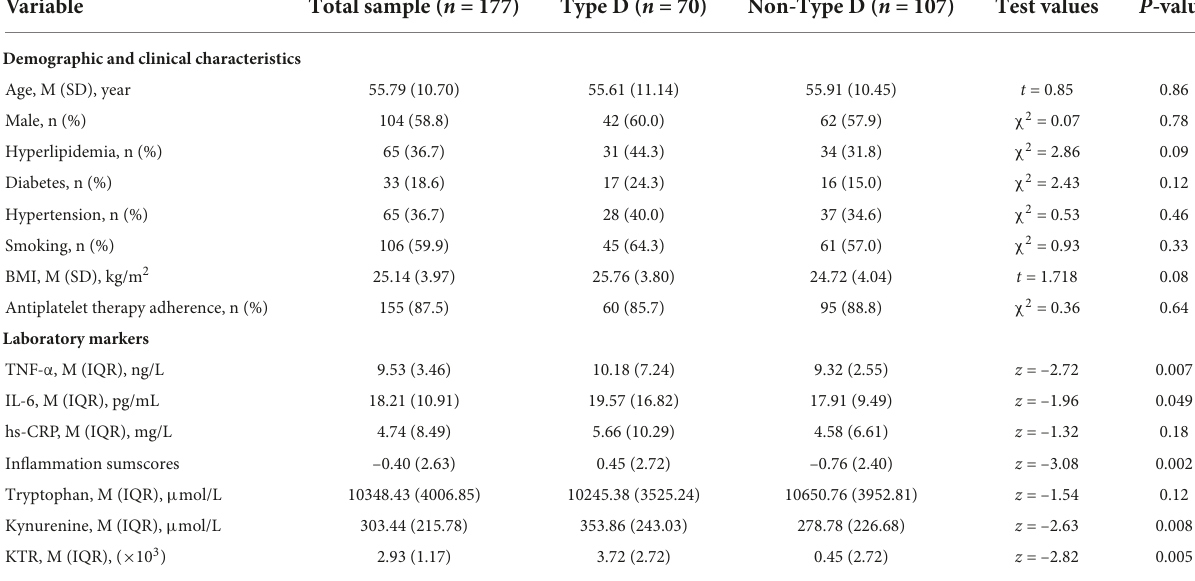
TABLE 1 Patients characteristics in Type D and non-Type D